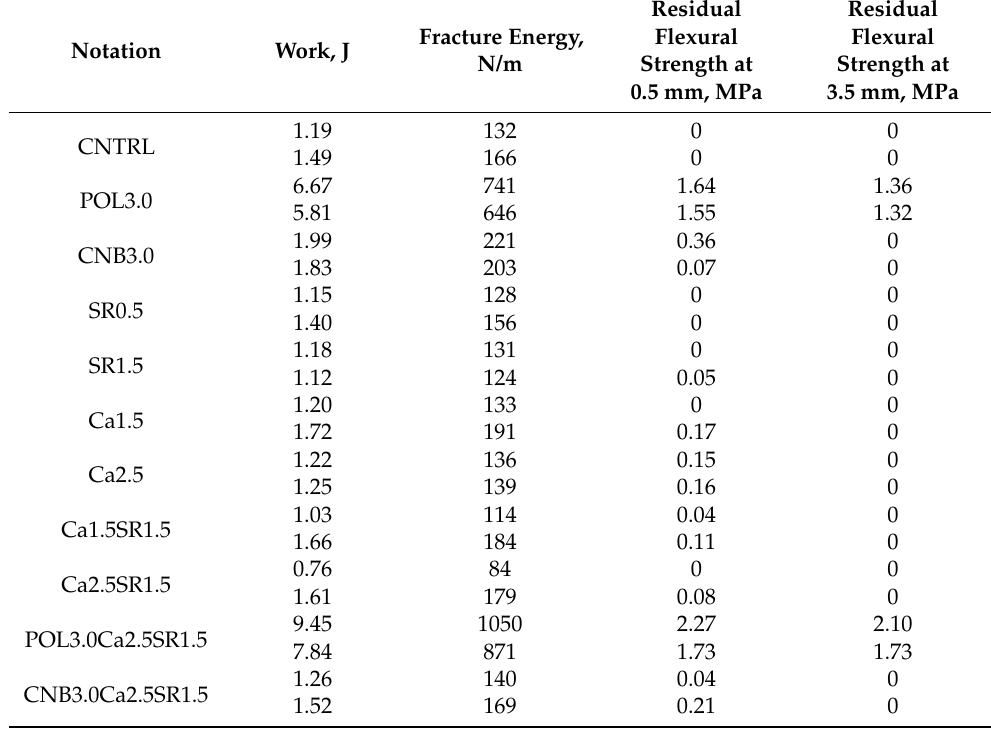
Table 4. Fracture energy used to break the specimens.